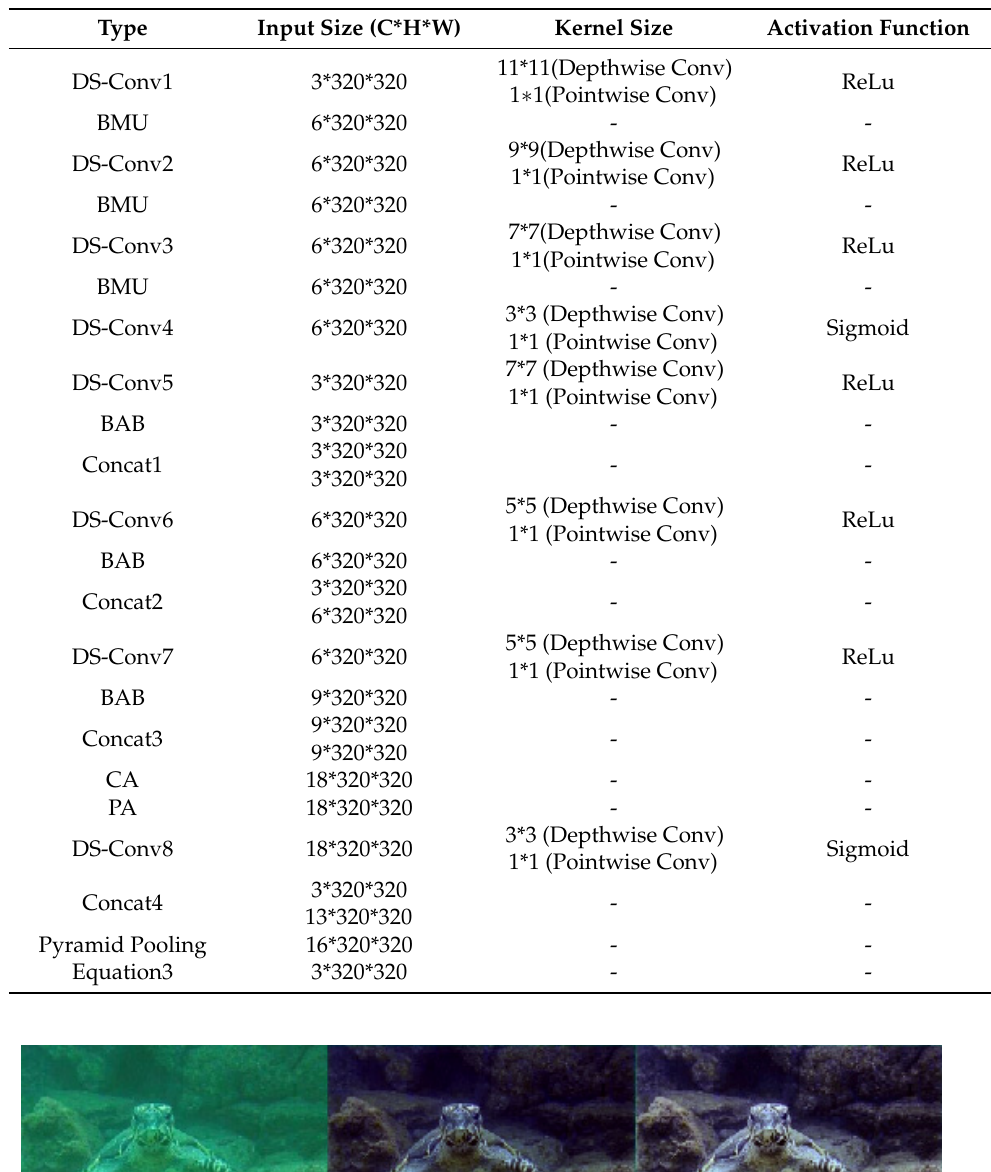
Table 1. The parameter settings of the UD-Net model.